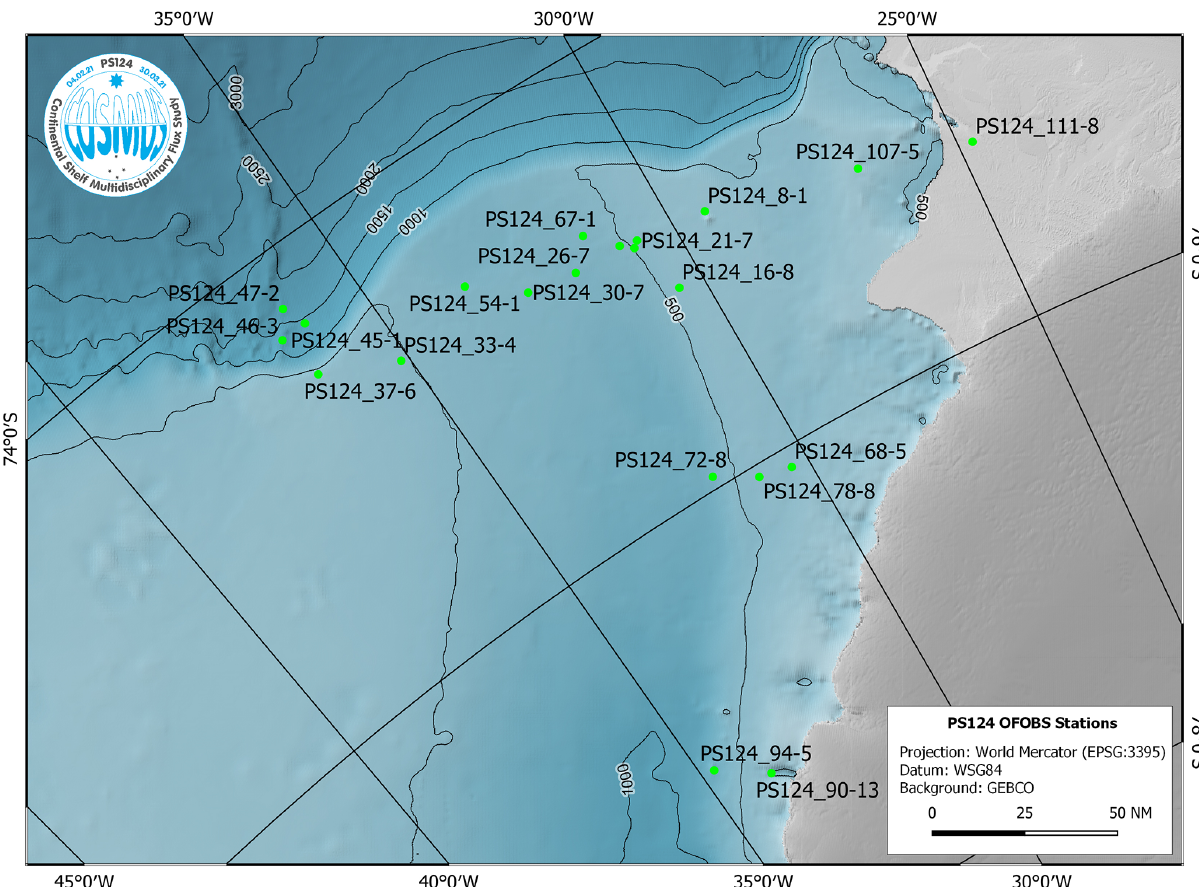
Figure 2. Regional map showing the positions of OFOBS deployments made during RV Polarstern cruise PS124. Deployment PS124_111-8 was made only a few weeks after the A74 iceberg Brunt Ice Shelf calving